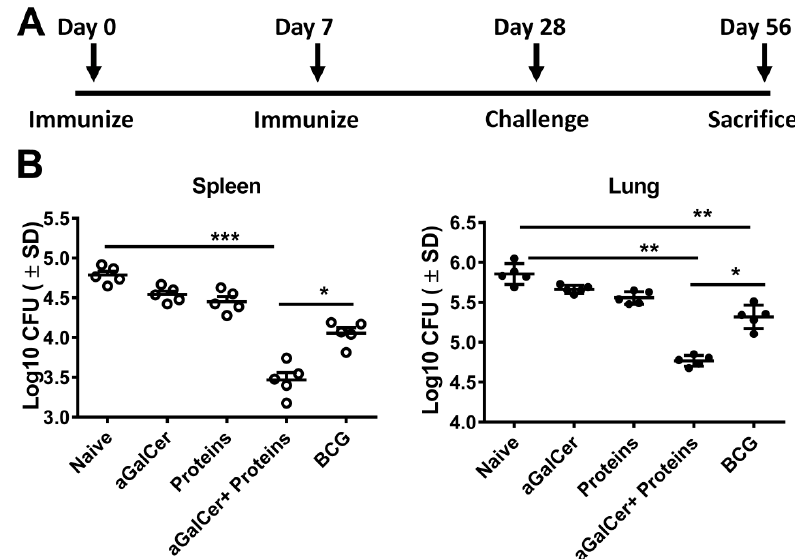
Figure 4. Sublingual immunization with Mtb proteins Ag85B and ESAT-6 in the presence of α -GalCer adjuvant significantly reduces pulmonary and extra-pulmonary bacterial load: C57BL/6 female mice were immunized by the sublingual route twice at 7 day intervals with a mixture of the recombinant Mtb proteins Ag85B and ESAT-6 in the presence and absence of the adjuvant α -GalCer ( α -GalCer + Proteins and Proteins, respectively) or with adjuvant alone ( α -GalCer) or Bacillus Calmette-Guerin (BCG) or untreated (naïve) and challenged on day 28 with Mtb by aerosol. (Panel ( A )): The bacterial burden in the spleens (Panel ( B ), left) and lungs (Panel ( B ), right) of mice in the different groups were analyzed on day 56 (28 days post challenge) as described in the methods section. Significantly lower (**, p < 0.005) bacterial burden in the spleens of mice vaccinated with either BCG or the Mtb proteins in the presence of α -GalCer adjuvant were observed when compared to naïve mice. Similar analysis in the lungs also showed significantly lower (***, p < 0.0005) bacterial burden in mice vaccinated with the Mtb proteins in the presence of α -GalCer adjuvant when compared to naïve mice. In both spleens and lungs of mice vaccinated with Mtb proteins in the presence of α -GalCer adjuvant the bacterial burden was significantly lower (*, p < 0.05) than those in mice immunized with BCG. Data shown are from one of two separate experiments each with groups of 5 mice.